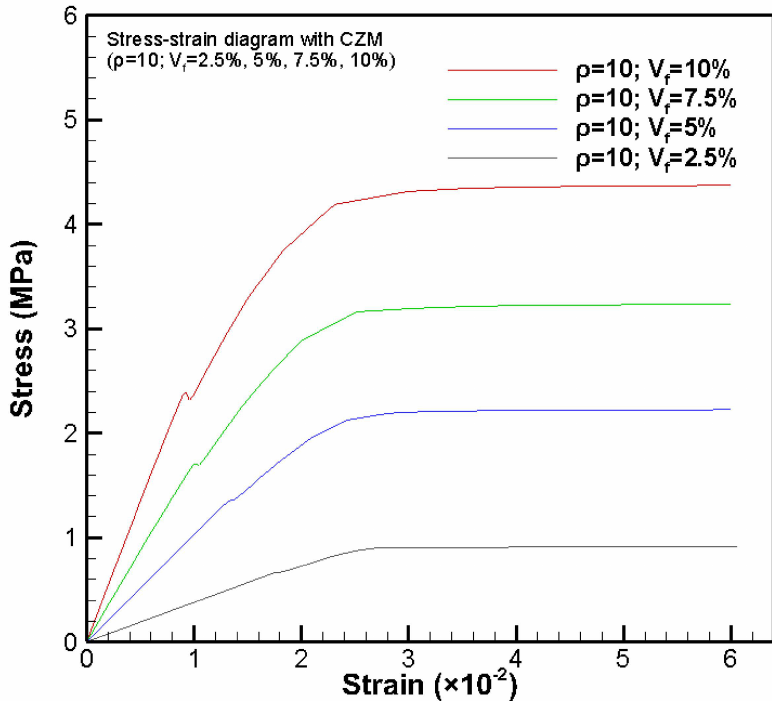
Figure 12. Effective stress-strain diagrams of the PNC (stack nanoparticle configuration) with CZM at the nanoparticle volume fraction of V f = 2.5%, 5%, 7.5%, and 10%, respectively ( ρ = 10).